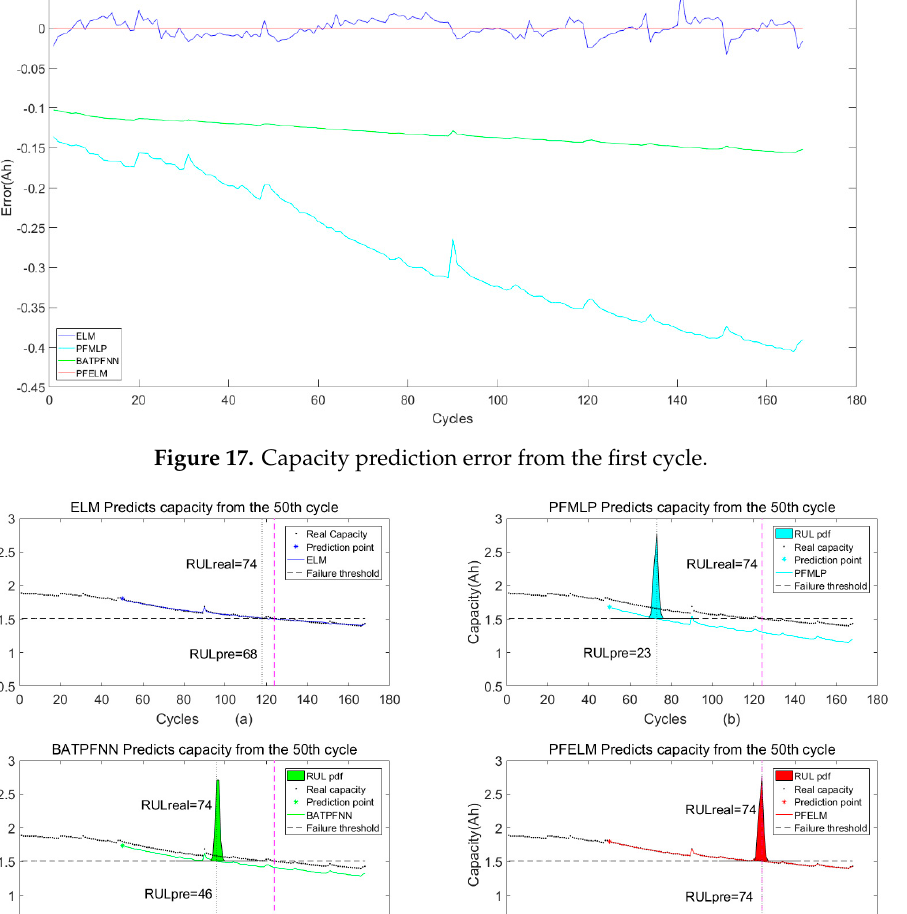
Figure 18. Predicting capacity from the 50th cycle by different algorithms: ( a ) ELM ; ( b ) PFMLP; ( c ) BATPFNN; ( d ) PFELM.